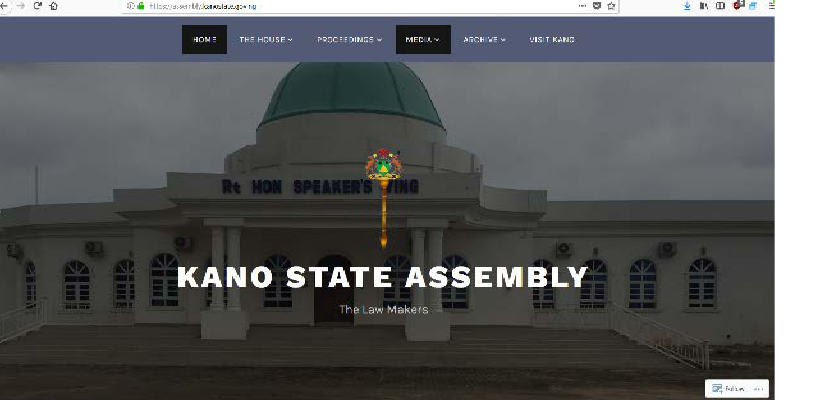
Figure 3: Kano State House of Assembly Official Website (https://assembly.kanostate.gov.ng)